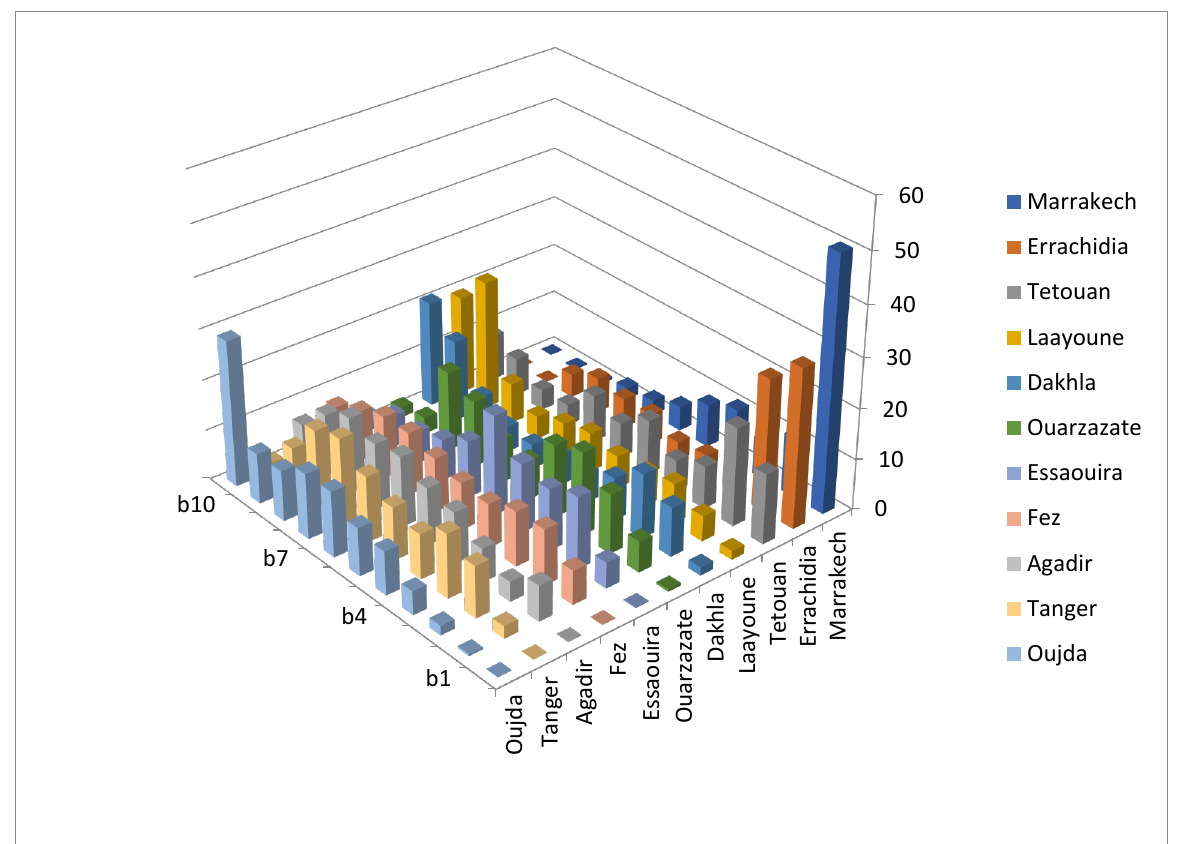
Figure 8. Third analysis with EPI as a new criterion. Rank acceptability indices for alternatives sorted according to their acceptability indices.